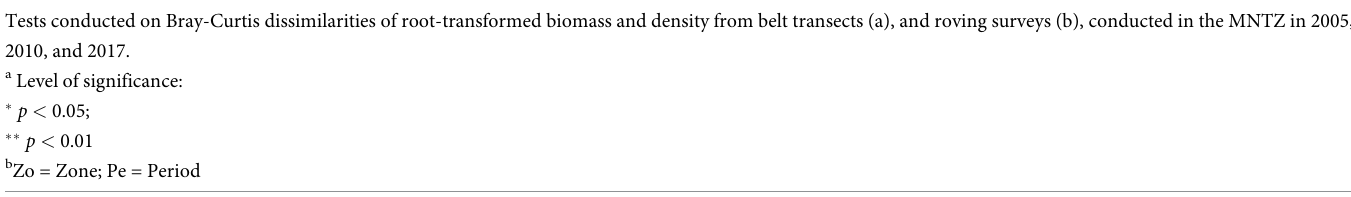
density between periods (Table 6). A significant change in multivariate biomass between peri- ods was also detected at 10 of 11 reef sites. SIMPER analysis indicated that yellowtail snapper ( O . chrysurus) and hogfish ( L . maximus) contributed most to density dissimilarities between periods within the inner-shelf zone, with 22% and 13% average dissimilarity, respectively (Fig 5b). Among mid-shelf sites, yellowtail snapper contributed nearly half (46%) of the total dis- similarity in densities between periods, with the greatest overall changes coming from San Cristobal reef (Fig 5c and 5d). As with nearshore zones, at the shelf edge, yellowtail snapper